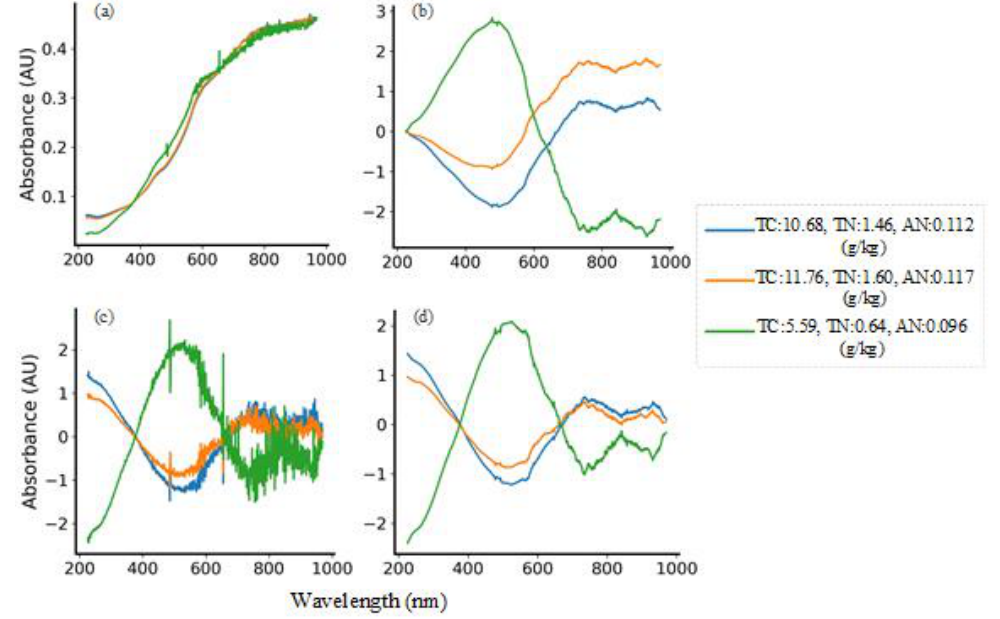
Figure 6. Preprocessed spectra of ( a ) S-G+MSC ( b ) S-G+Centralization ( c ) MSC+Centralization ( d )